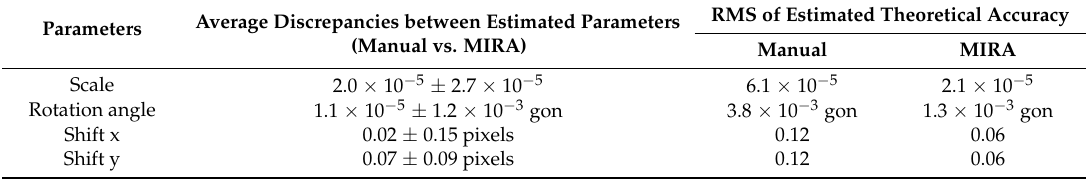
Table 7. Comparison between results obtained with manual and automatic (MIRA) processing of ‘Multan’